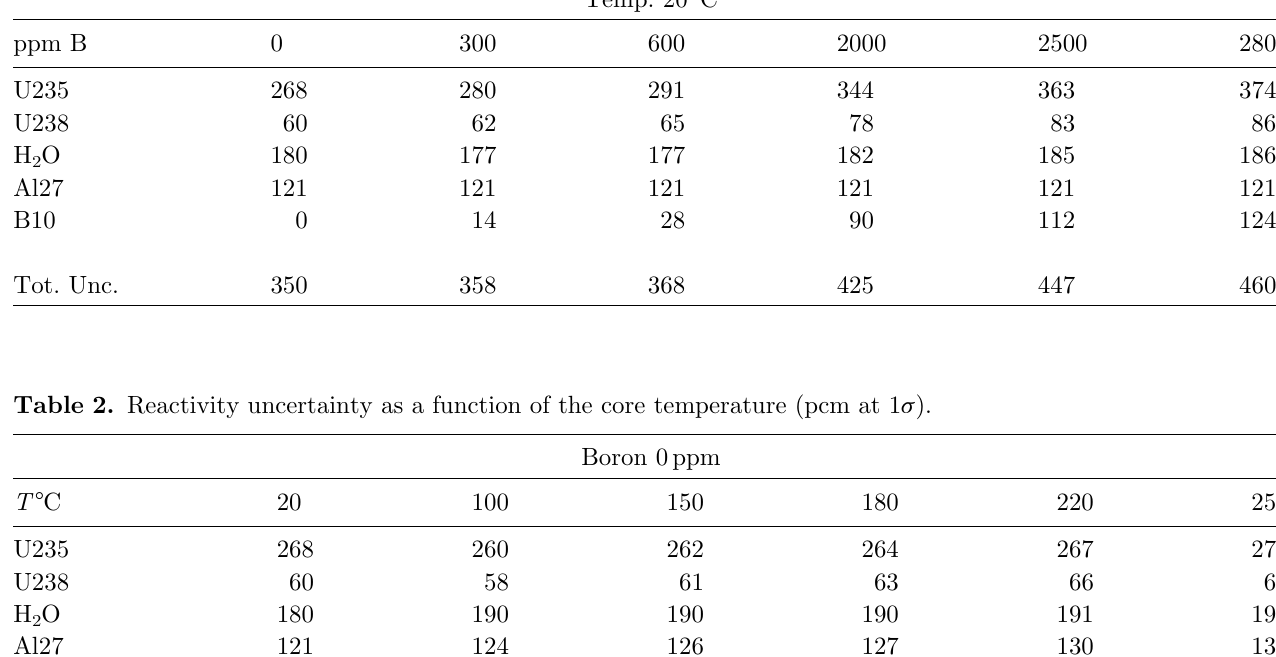
Table 1. Reactivity uncertainty as a function of the soluble boron concentration (pcm at 1 s ).